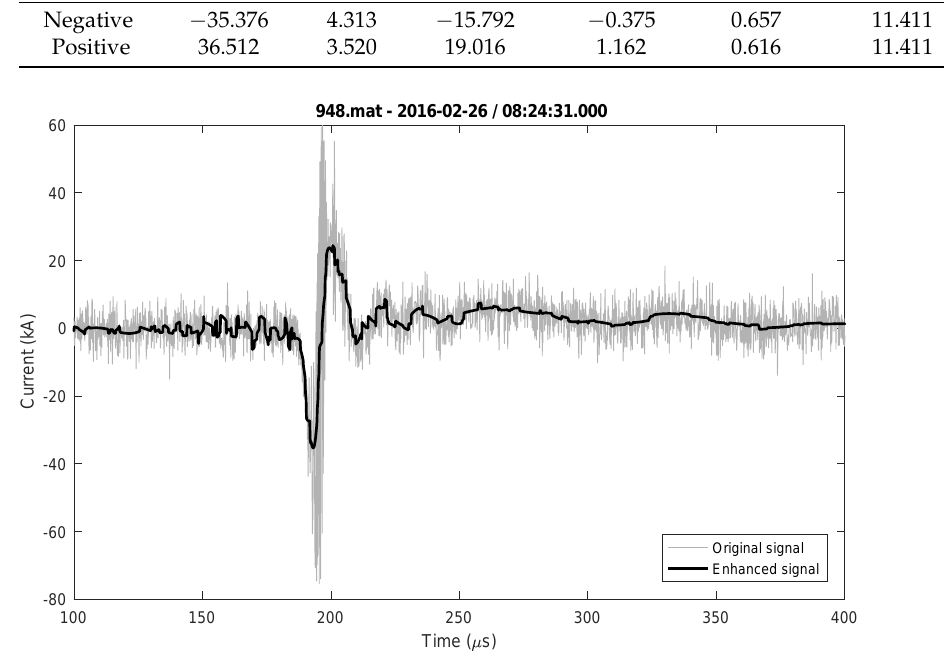
Figure 12. Bipolar lighting flash original and enhanced